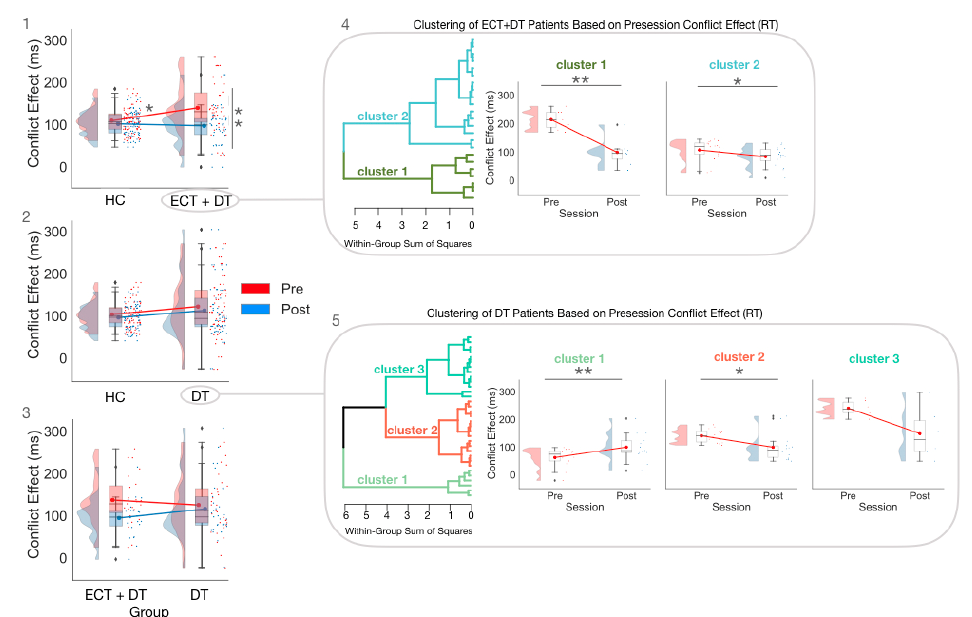
Figure 3. The Group × Session ANOVAs estimated on the CE (RT), with panel ( 1 ) showing the comparison between HC and ECT + DT, panel ( 2 ) showing the comparison HC vs. DT, and panel ( 3 ) showing the comparison between ECT + DT and DT, and subsequent Session × Cluster ANOVAs conducted separately for the ECT + DT (panel ( 4 )) and DT (panel ( 5 )) clusters. * p < 0.05; ** p < 0.01. ♦ indicates outlier.